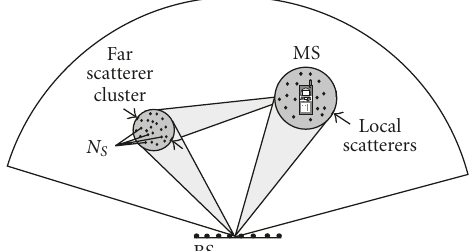
Figure 4: Principle of the GSCM (BS—base station, MS—mobile